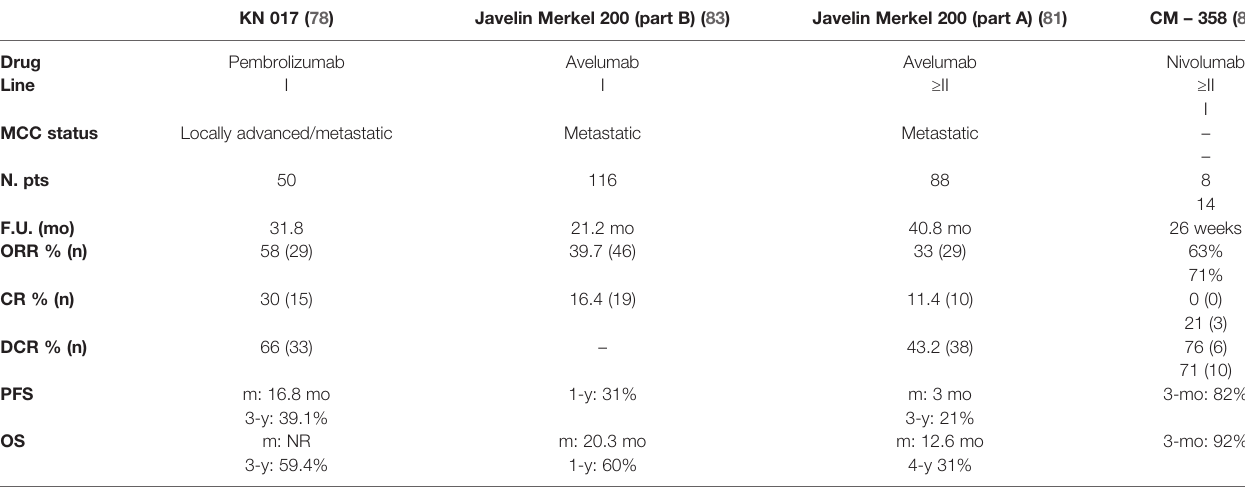
TABLE 2 | Summary of all clinical trials with immunotherapy for the treatment of locally advanced and/or metastatic